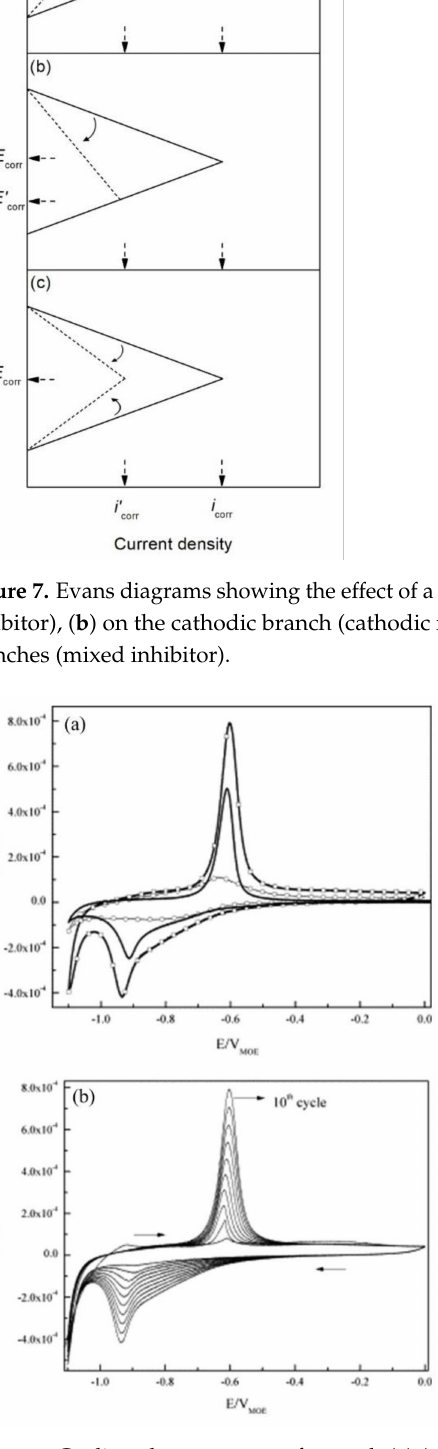
Figure 8. Cyclic voltammograms for steel: ( a ) (tenth cycle) in PSS (—), PSS + Cl − (– (cid:3) –), PSS + Cl − + PO 4 3 − (– –), and ( b ) cycles 1–10th in PSS + Cl − . Scan rate: 10 mV s − 1 [60]. Reproduced with (cid:35) permission from Yohai, L. et al., Electrochim. Acta; Published by Elsevier,